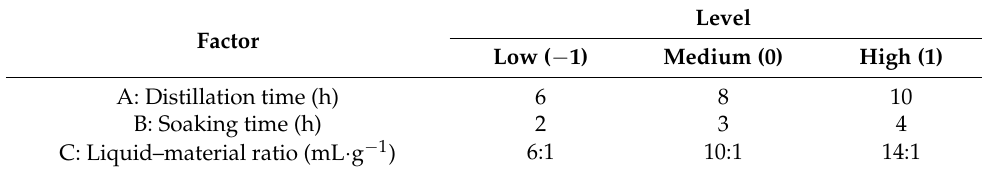
when there are three 3-level factors. For example, there are 29, 17, and 13 runs for the full three repetitions of the center point, respectively. The volatile oil yield was considered as the evaluation index. The factor levels are shown in Tables 1 and 2. Table 1. Factors and levels of the Box–Behnken design.